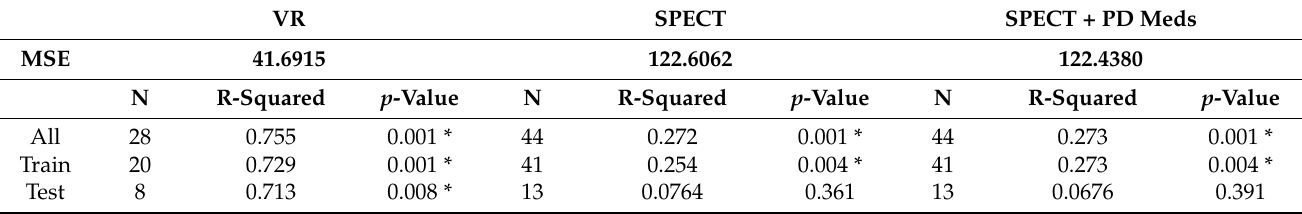
Figure 3. Scatter plots showing target versus predicted UPDRS-III scores with VR ( A ) and [ 123 I]FP-CIT SPECT ( B ) obtained using a regression SVM machine learning model for the entire data set. Linear regression lines show correlation between target versus predicted UPDRS-III scores (continuous lines) and target versus target scores (dashed lines). Table 5. MSE and R-squared coefficients for VR, [ 123 I]FP-CIT SPECT, and SPECT + PD Meds in prediction of UPDRS-III motor score with SVM.